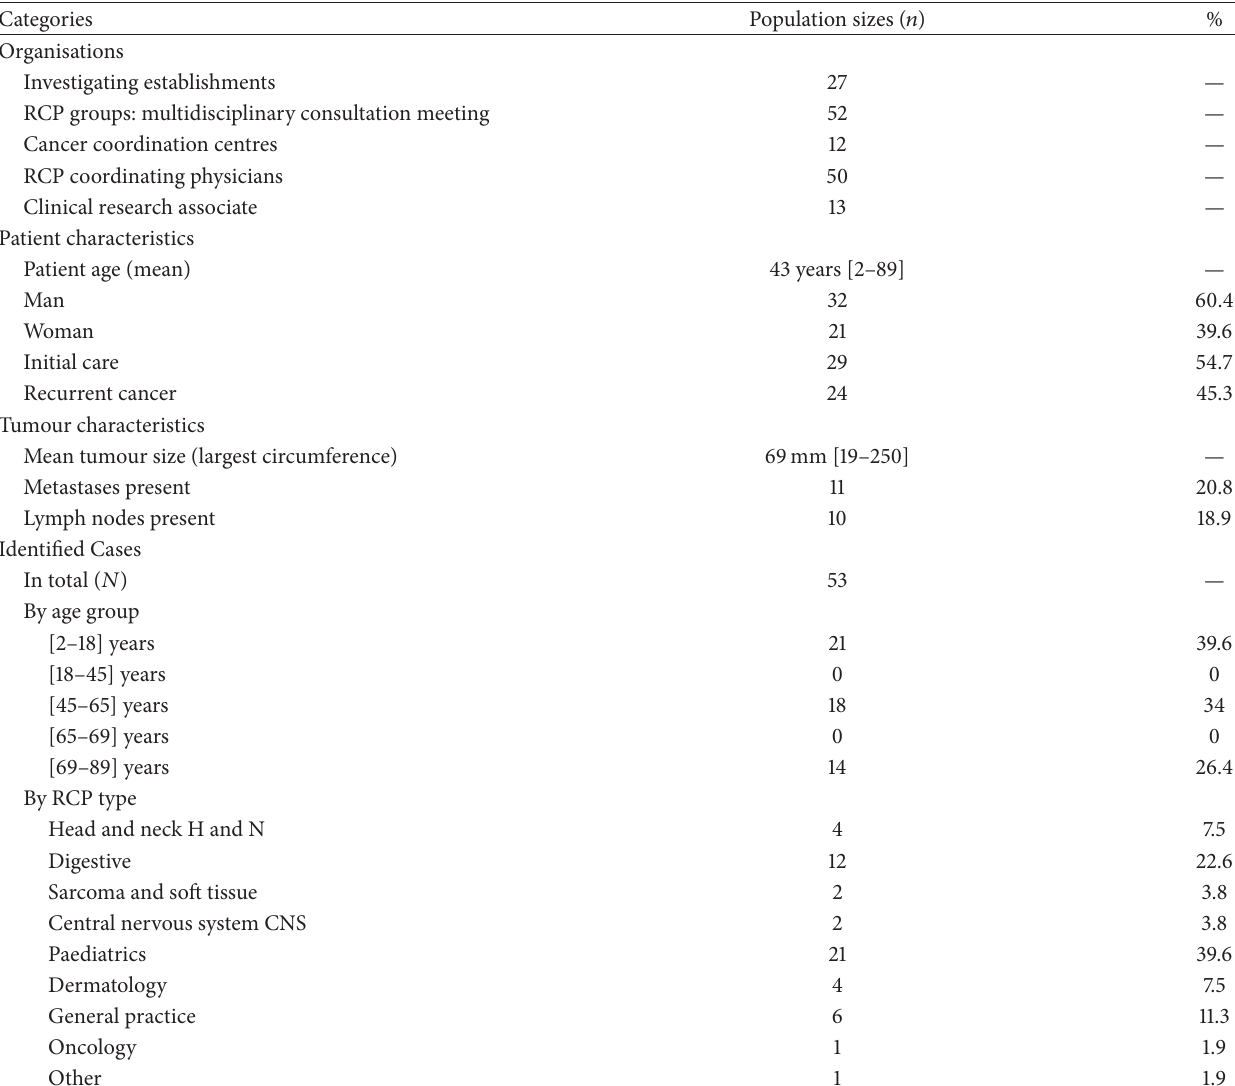
Table 3: Results, EpiHadron study: organisation, patient, and tumour